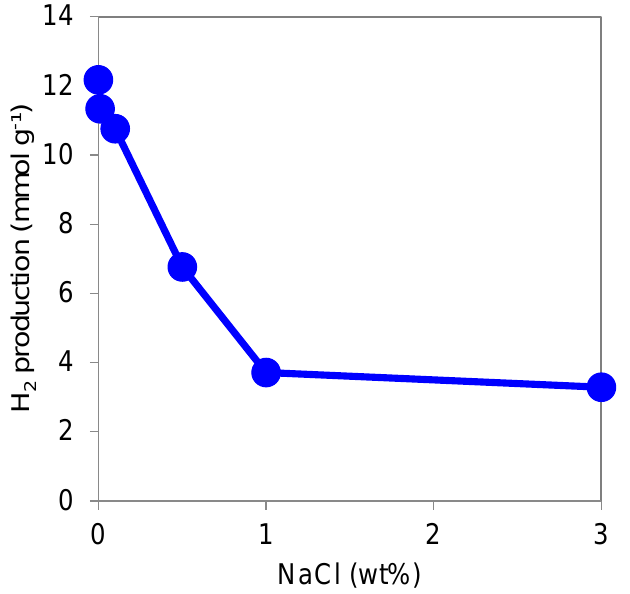
Figure 6. Effect of NaCl concentration. TiO 2 , 50 mg; Rh, 1.25 ppm; reaction time, 3 h; reaction temperature, 50 ◦ C; formic acid concentration, 1 wt%.